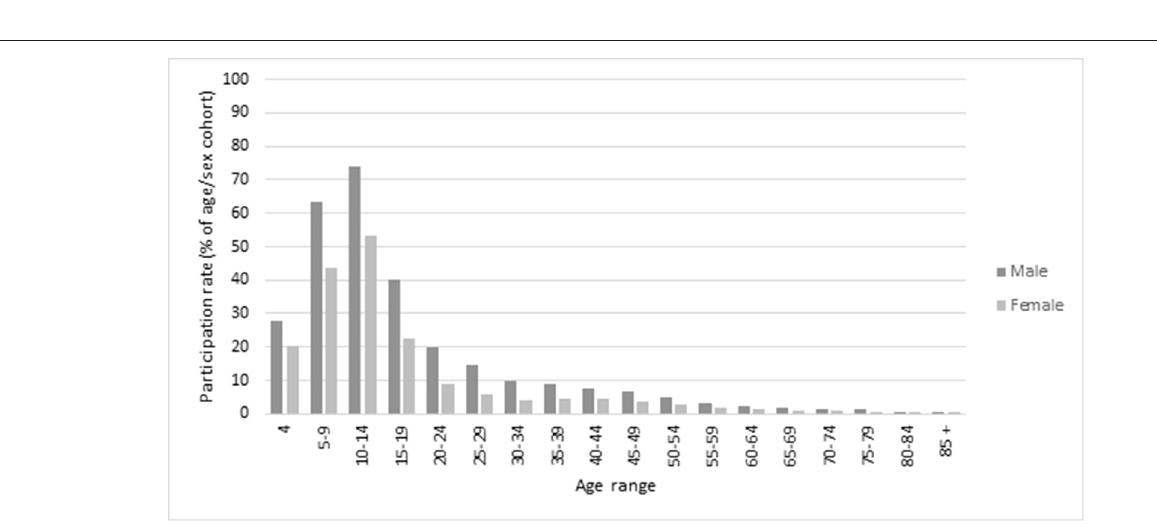
two sports gender-neutral with very similar participation rates for both